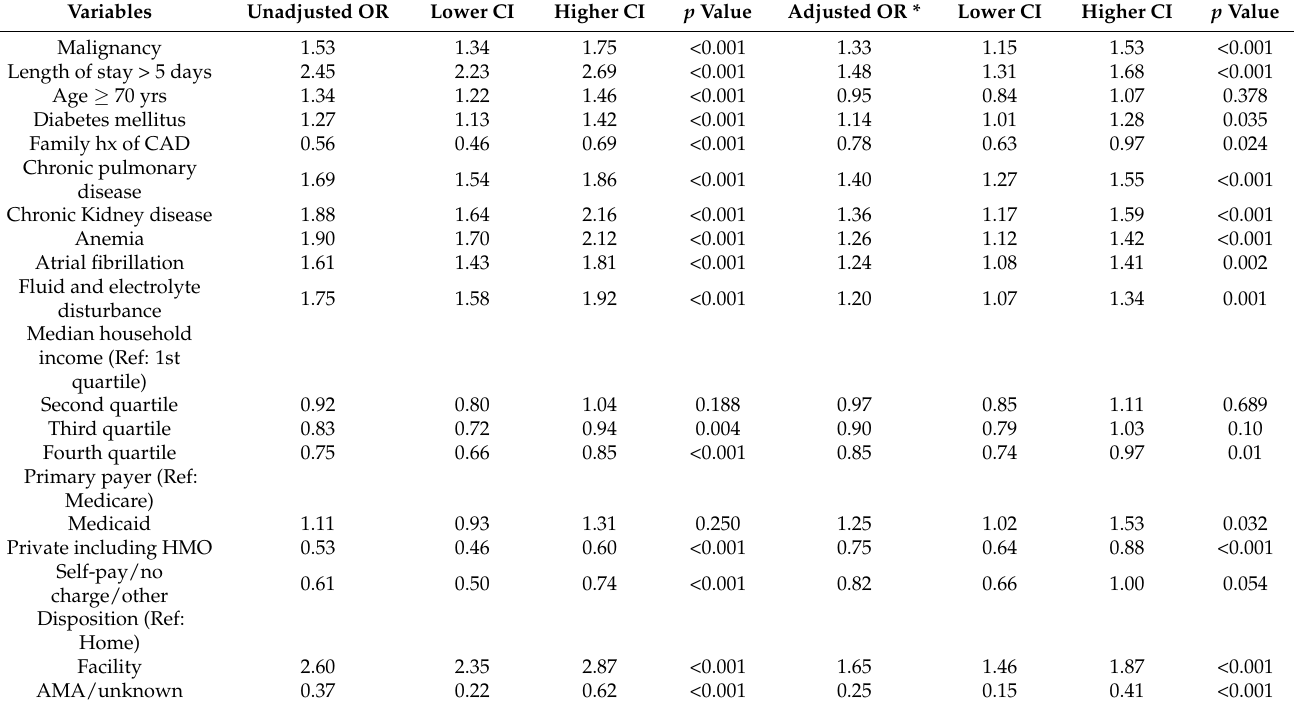
Figure 2 and Figure S1 demonstrate the timing of a 30-day readmission stratified by the presence of malignancy. The median time to readmission was longer in TTS patients with malignancy vs. without malignancy (12 days, interquartile range (IQR) 5–19